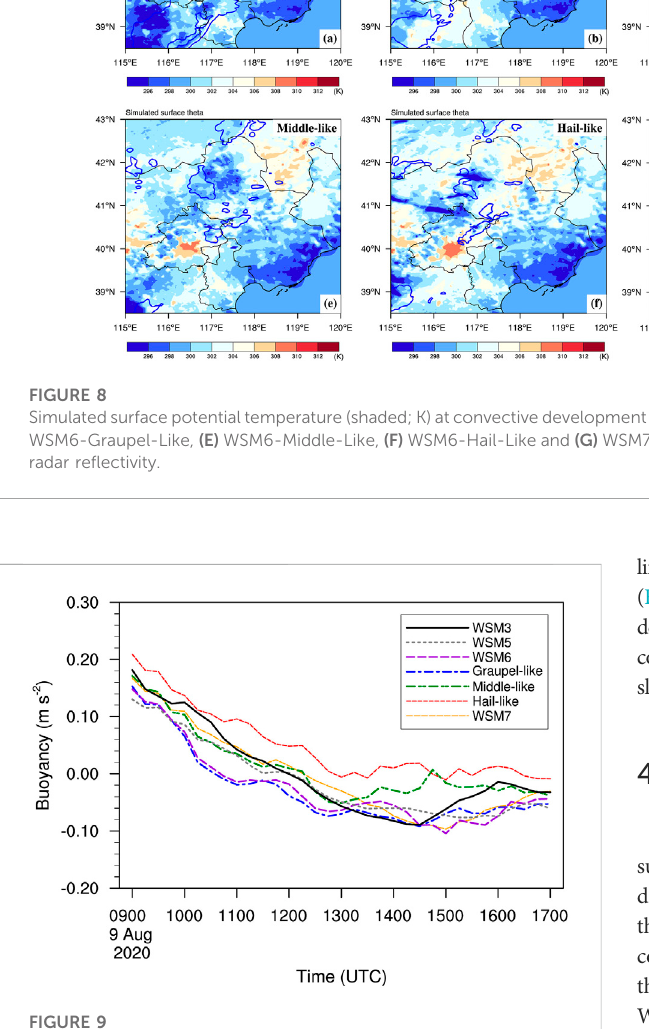
FIGURE 9 Time series of simulated area-averaged surface buoyancy (units: m s − 2 ) of cold pools within the whole convection bands for all seven experiments beginning at 0900 UTC 9 August